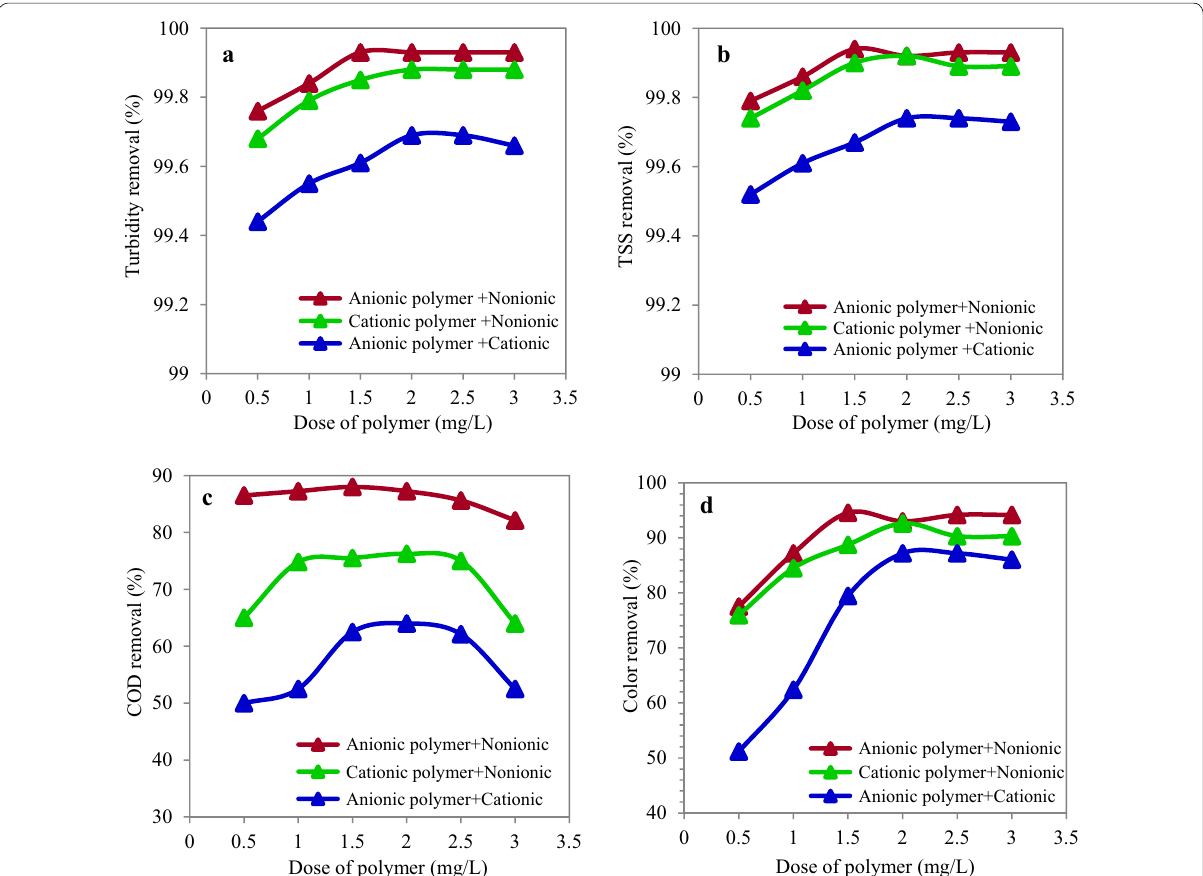
Fig. 6 Turbidity ( a ), TSS ( b ), COD ( c ) and color ( d ) removal efficiency in different dose of combined polymers (at pH